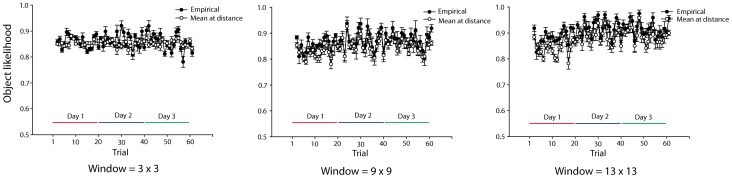
Object information per fixation as a function of practice calculated for three fields of view.Separate lines for the empirical fixations (black) and the average information of image locations at the same distance from the image center (white). Error bars are SEM across subjects.